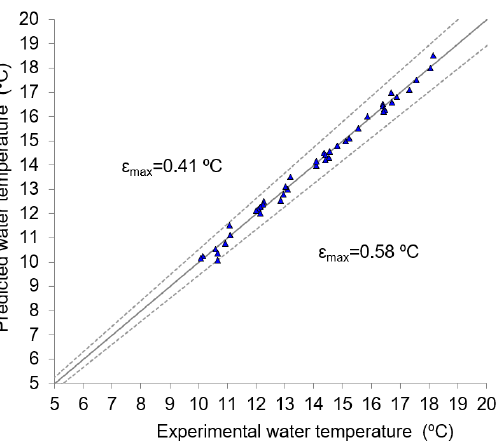
Figure 12. The deviation between calculated and experimental values of the wall temperature.